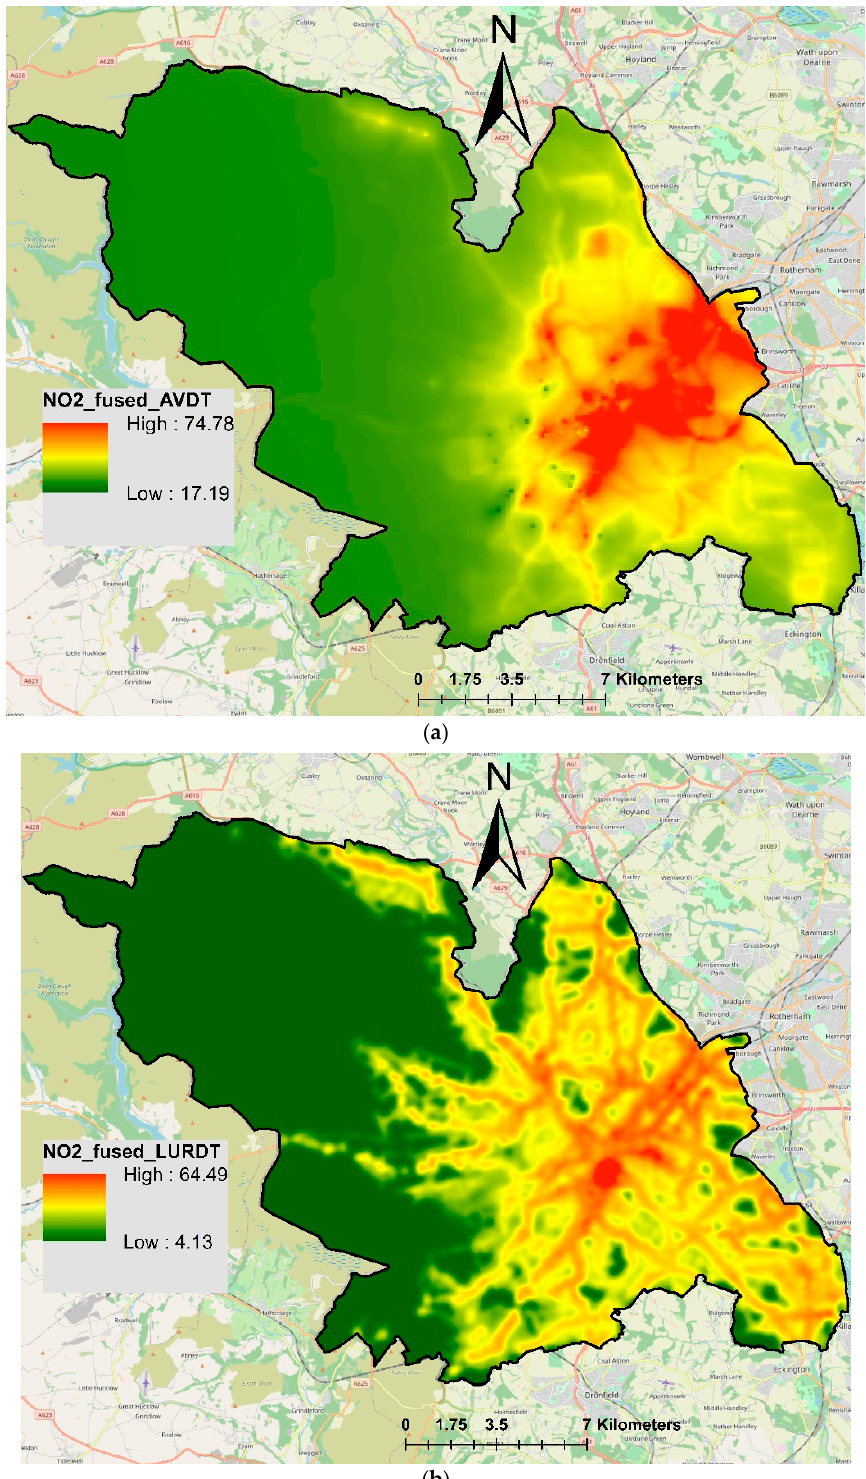
Figure 8. Resulting maps of fused NO 2 concentrations (µg/m 3 ) using universal kriging techniques: ( a ) NO 2 Airviro-DT; ( b ) NO 2 LUR-DT. ( a ) NO 2 Airviro-DT; ( b ) NO 2